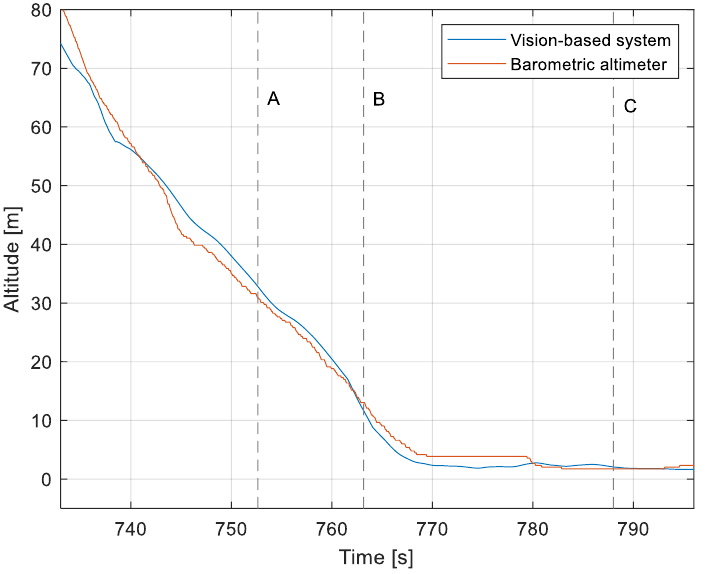
Figure 12. Altitude relative to the airside: Flight no. 3 (markers A–C correspond to the moment of recording the images in Figure 13).